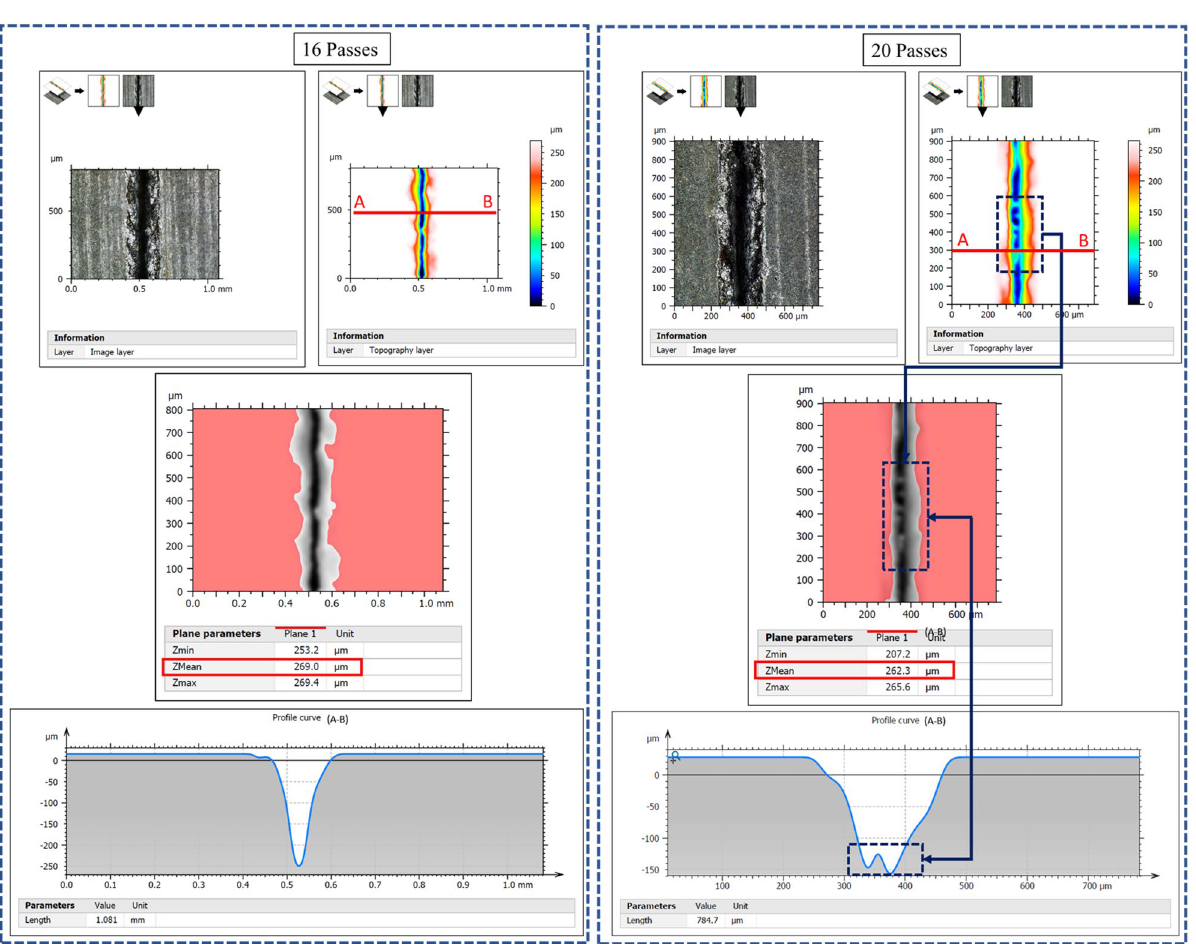
Figure 12. Line profile views and groove morphologies at 16 passes and 20